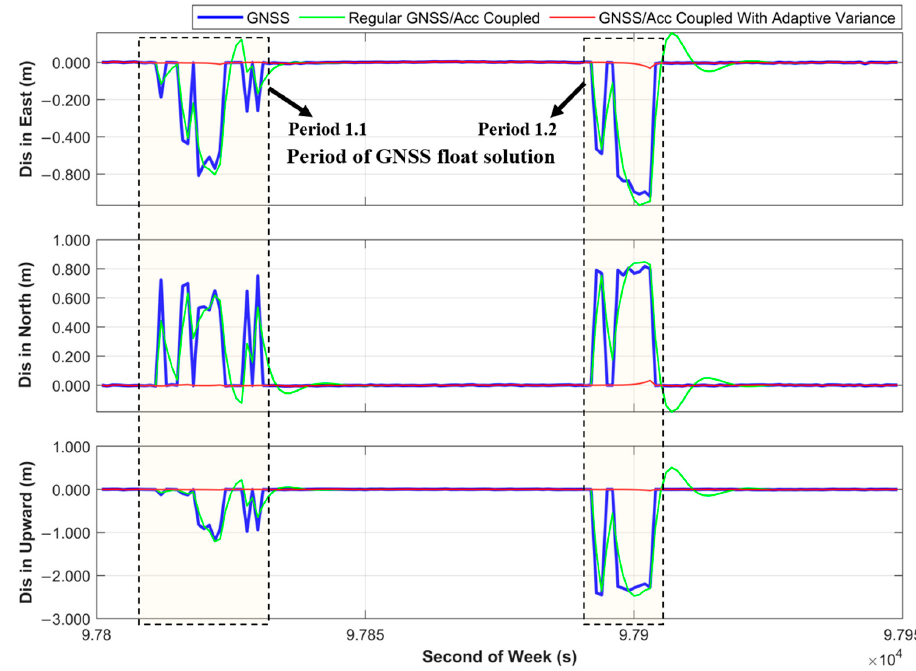
Figure 12. Coupled displacement results of the simulated landslide stability period in Scene 2.2.